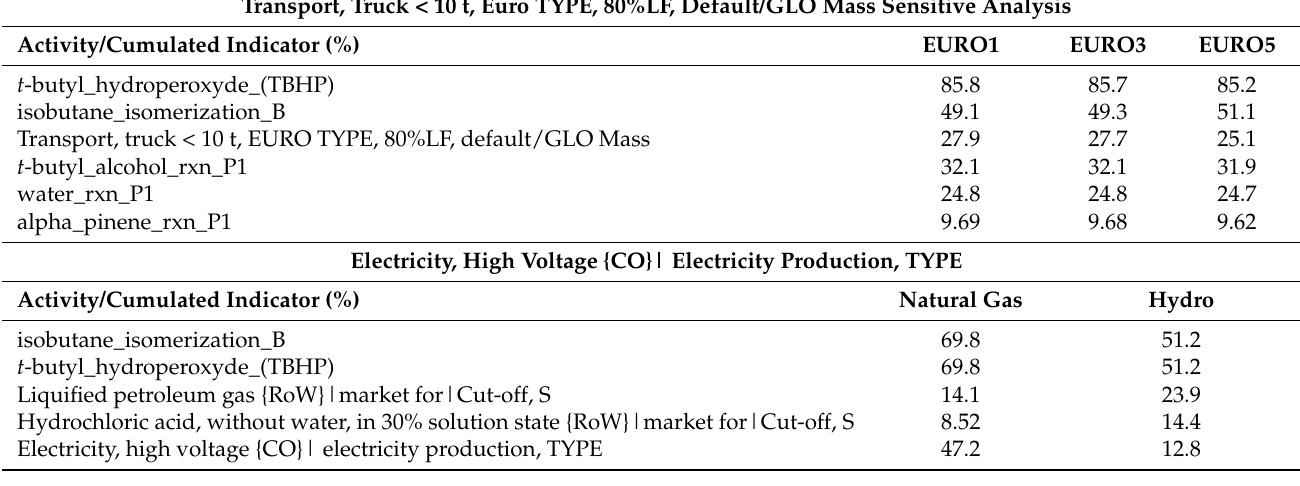
Table 4. Sensitivity analysis of transportation and electricity in the process for verbenone production in the SI-raw-oils scenario. Assessment method: ReCiPe 2016 Endpoint (H) V1.06/World (2010) H/A. Functional unit: 1 kg of verbenone/batch, cumulated indicator as